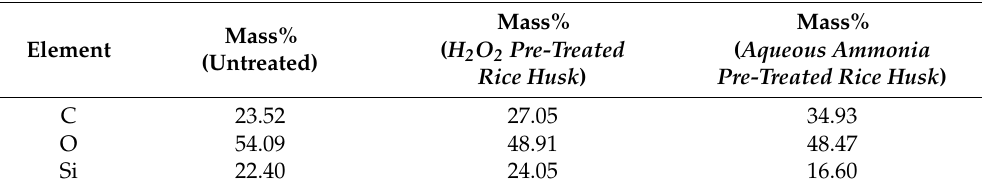
Table 2. EDS analysis of the element composition of untreated and pre-treated rice husk (ZAF method standardless quantitative